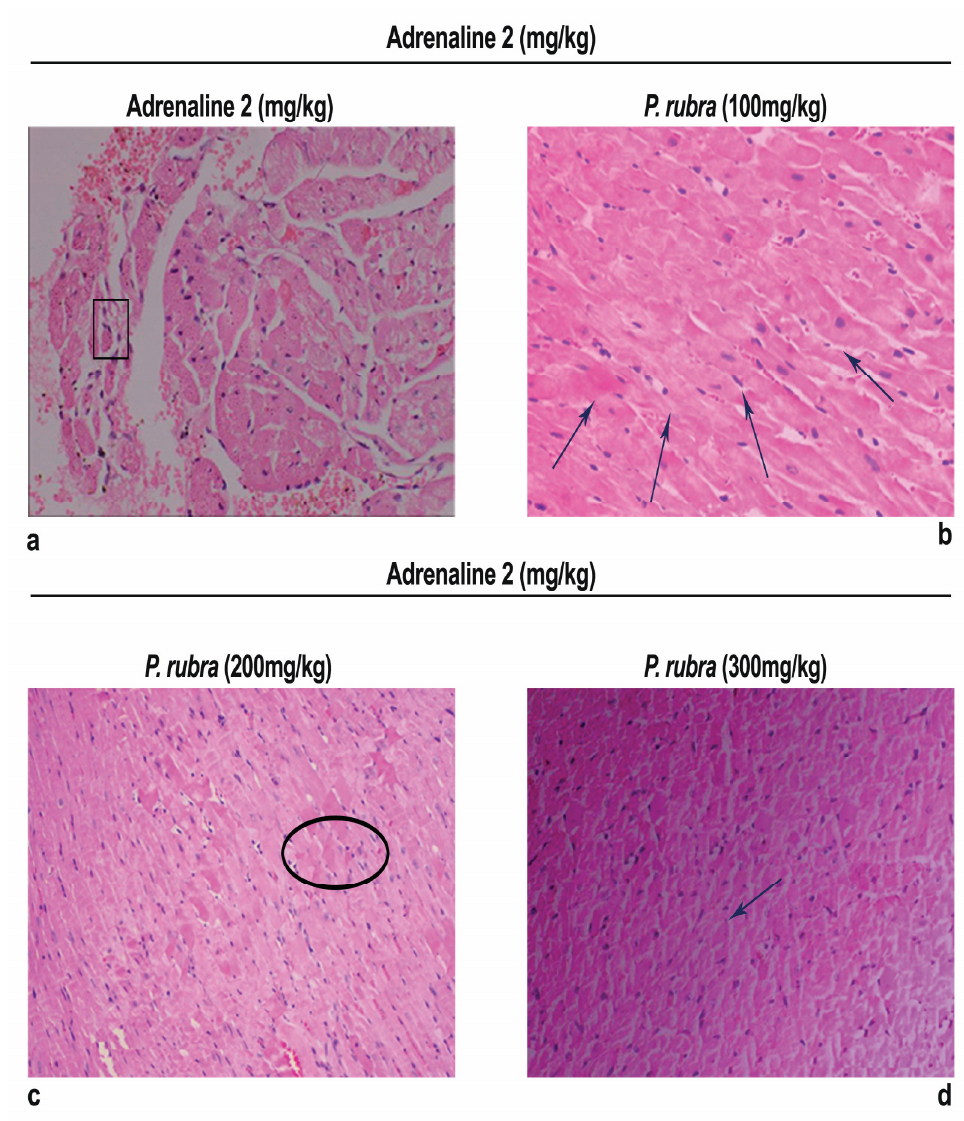
Figure 6. Photomicrograph showing histopathological variations of ventricle section of rabbit heart: ( a ) ADR-intoxicated group; ( b ) P.rubra 100 mg/kg + ADR; ( c ) P. rubra 200 mg/kg; ( d ) P. rubra 300 mg/kg + ADR. In comparison to the ADR-intoxicated group, less inflammatory cells, cardiomyocyte deterioration, infiltration and fibrosis were observed in a dose-dependent manner. Rectangular shape indicates enlarged cardiomyocytes, upward arrows indicate cellular infiltration, oval shape indicates cardiac fibrosis and downward arrows indicate dense normal cluster of cardiomyocytes. Magnification is ×